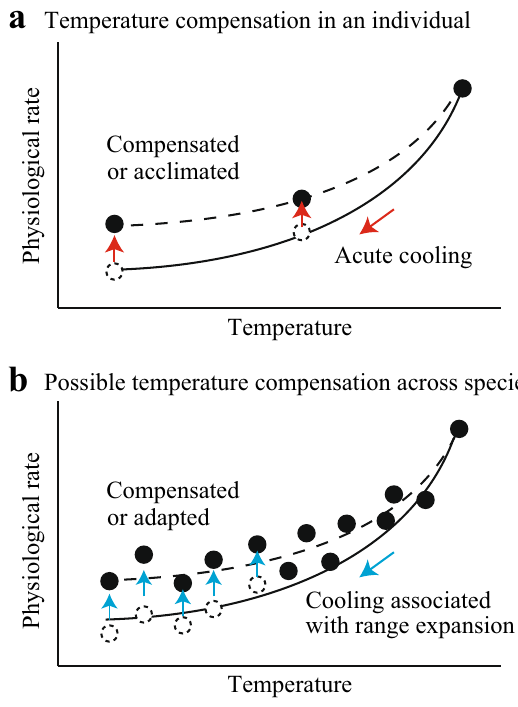
Fig. 1 | Conceptual graphs showing possible temperature compensation of physiological rate (e.g., metabolic rate) in an individual and among species over evolutionary time. a Experimentally induced acute cooling causes a rapid decline in physiological rate of an individual, but the rate can recover to some extents following suf fi cient time. This process is called acclimation and represents reversiblephenotypicchanges. b Acrossspecies,physiologicalratetendstodecline with decreasing environmental temperature. As such, range expansion into cold waters associated with speciation will cause a decline in physiological rate. How- ever, the effects oftemperaturemay be reduced compared to thatpredicted from the temperature dependence of individual animals, given that physiological remodeling occurs over evolutionary time. This unreversible temperature com- pensation could be called adaptation if it